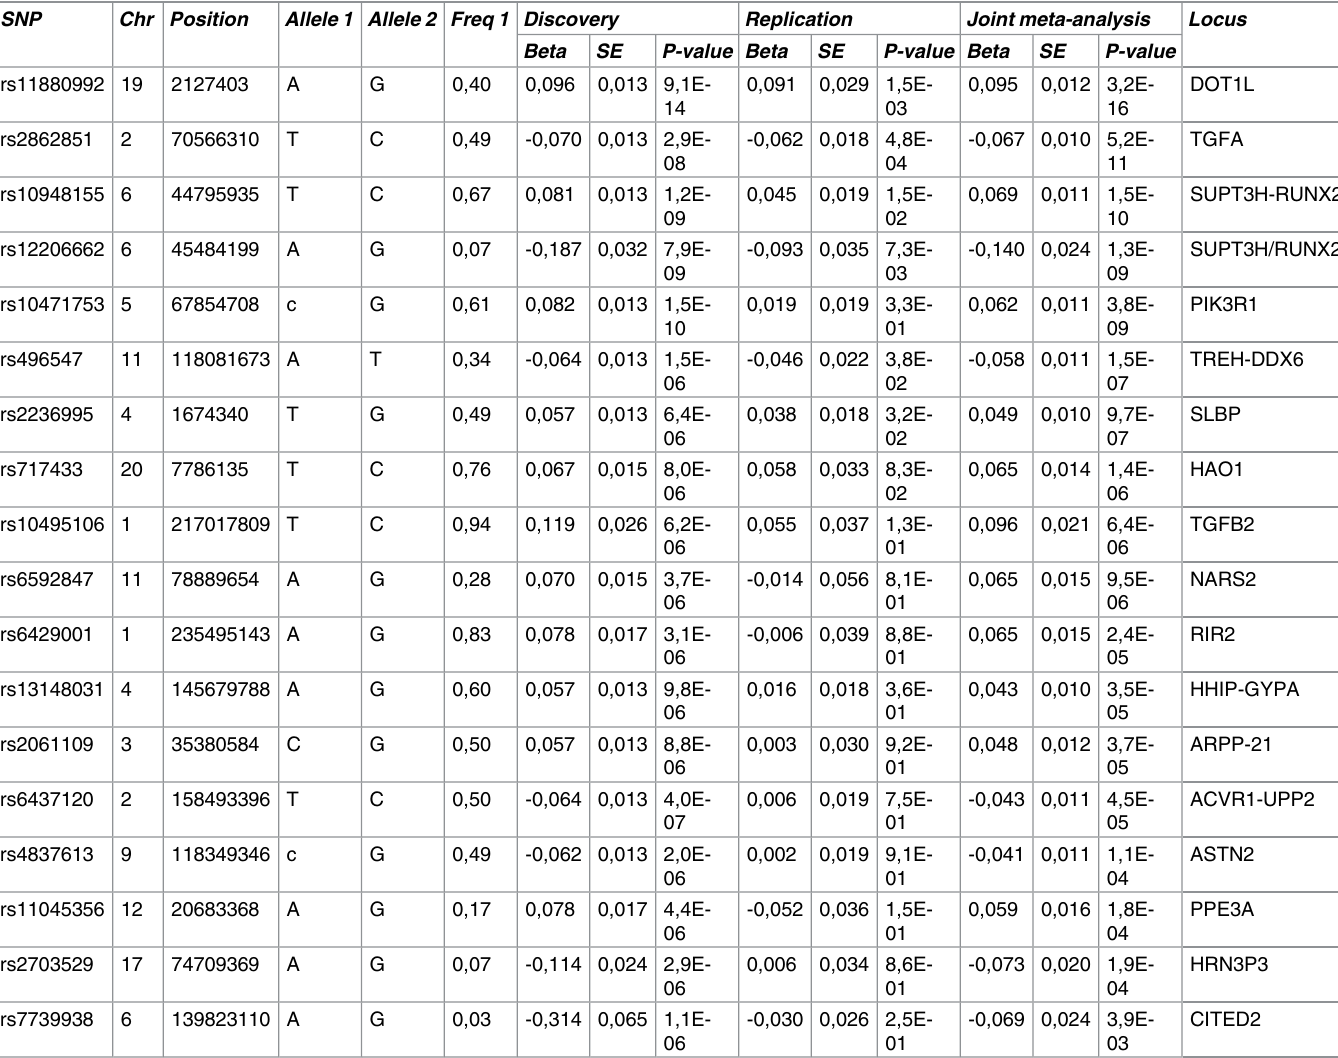
Table 1. Results from the minimal Joint Space Width genome-wide association study; discovery, replication and joint meta-analysis